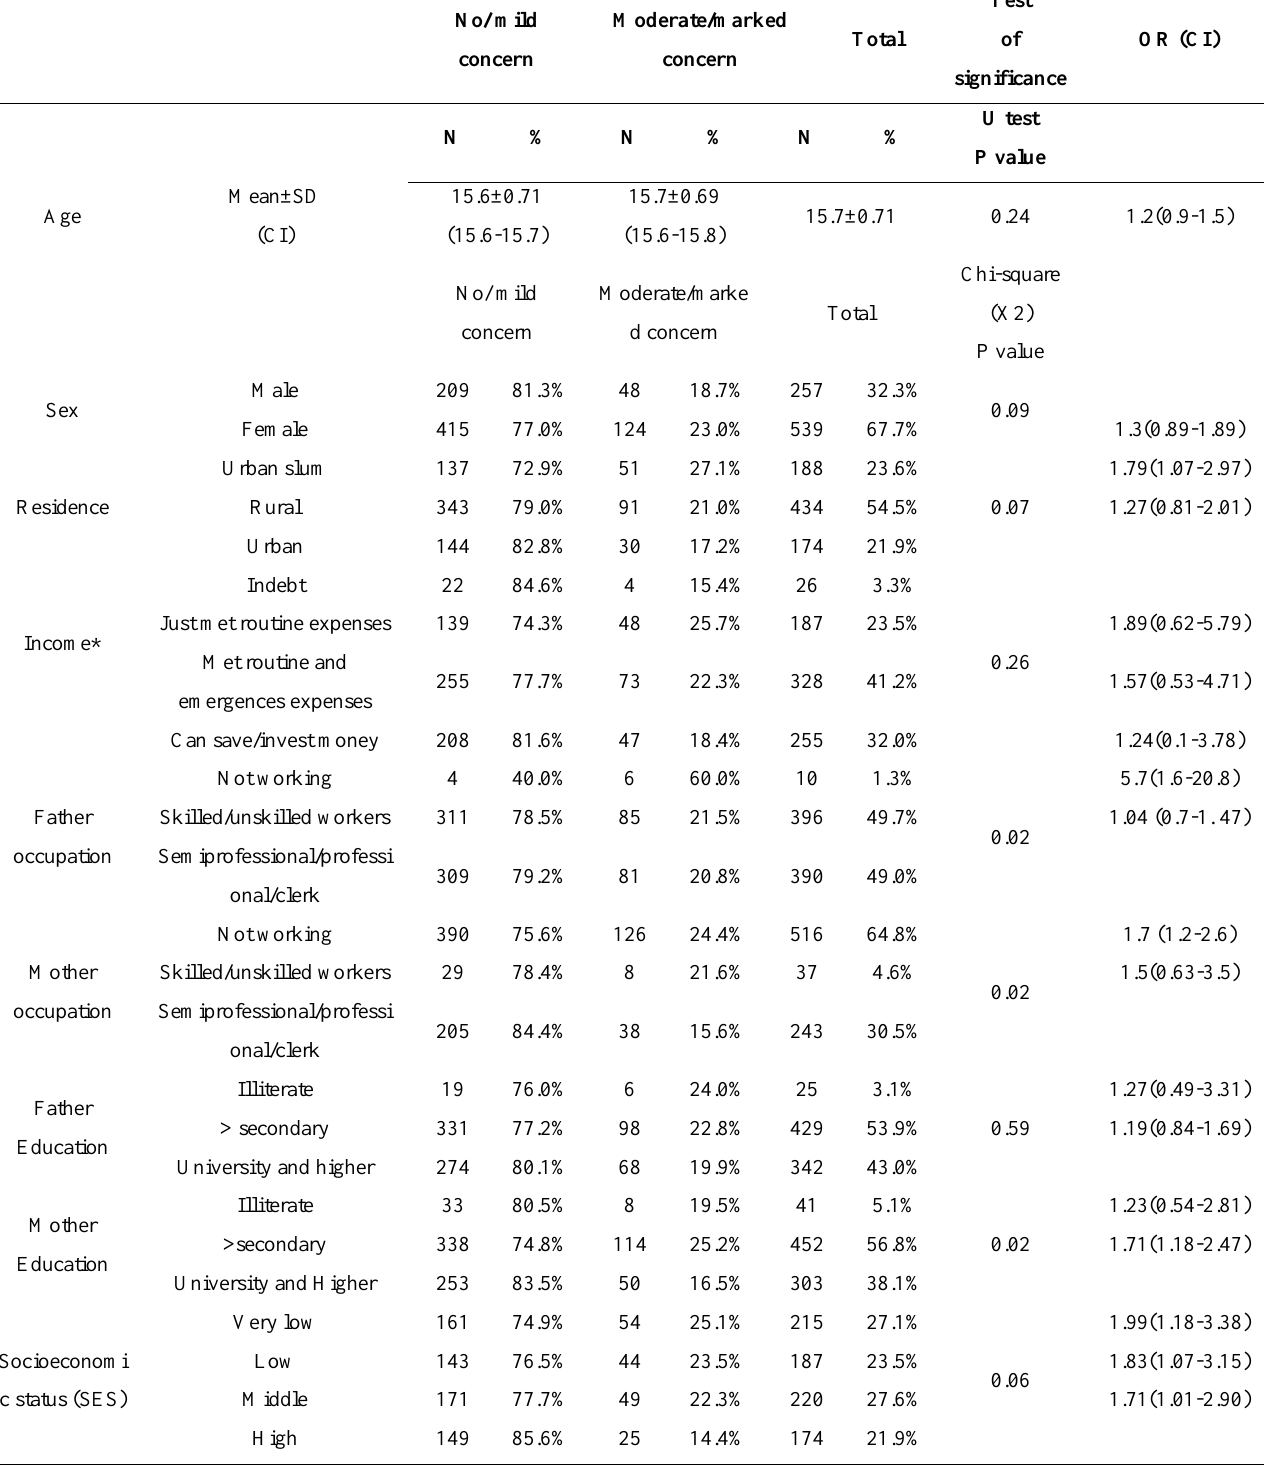
Table 1 : Socio-demographic characteristics of the studied group (N=796) by their body shape concern measured by Body shape questionnaire (BSQ-34)